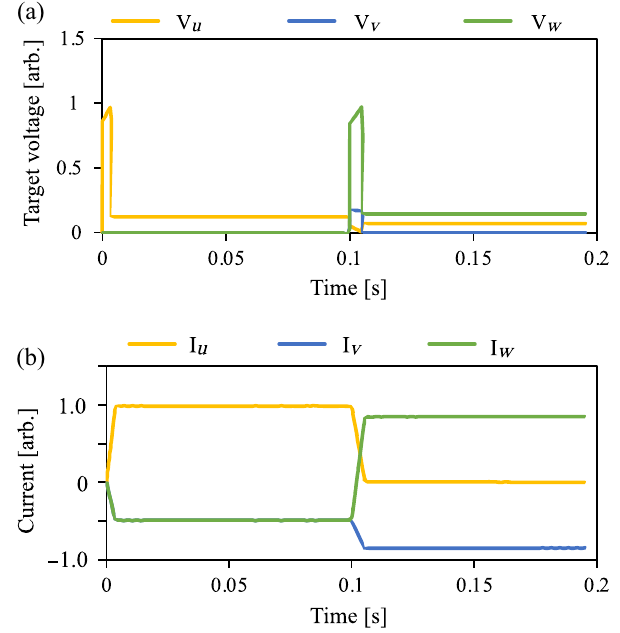
FIG. 9. Simulation of coil current control by a single power supply: (a) Target voltage for pulse width modulation control, (b) coil